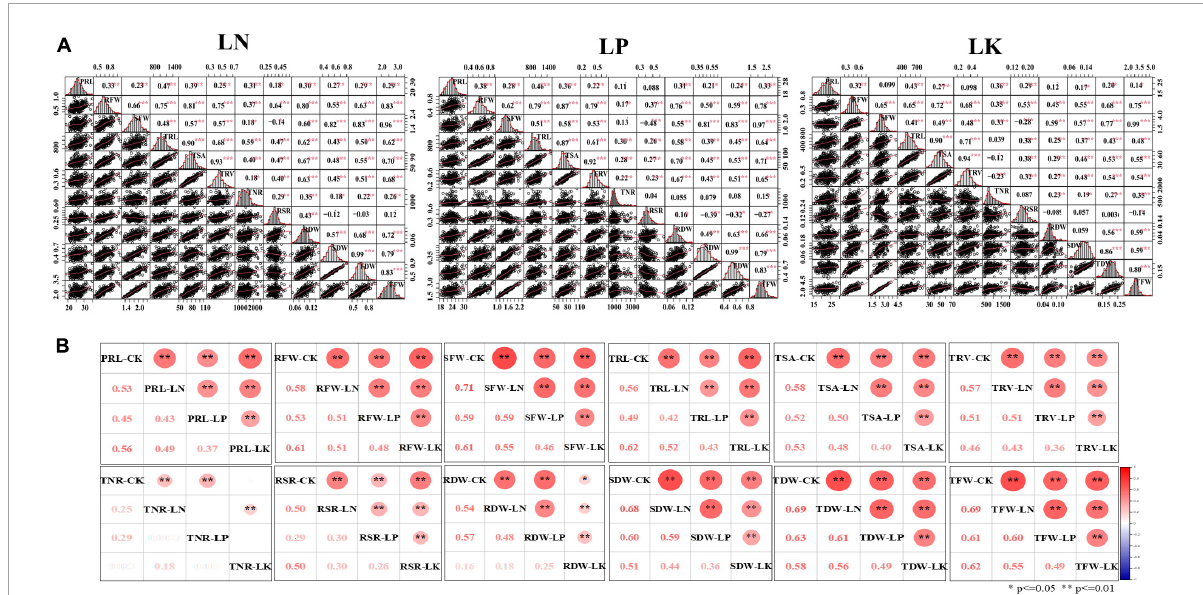
FIGURE2 Correlation, frequency distribution and scatter plot analysis of the investigated root and biomass traits. (A) Correlations of captured traits under LN/LP/LK. (B) Correlations of each captured trait among the four treatment conditions (CK/LN/LP/LK). **, * Significant at 1 and 5% levels of probability,